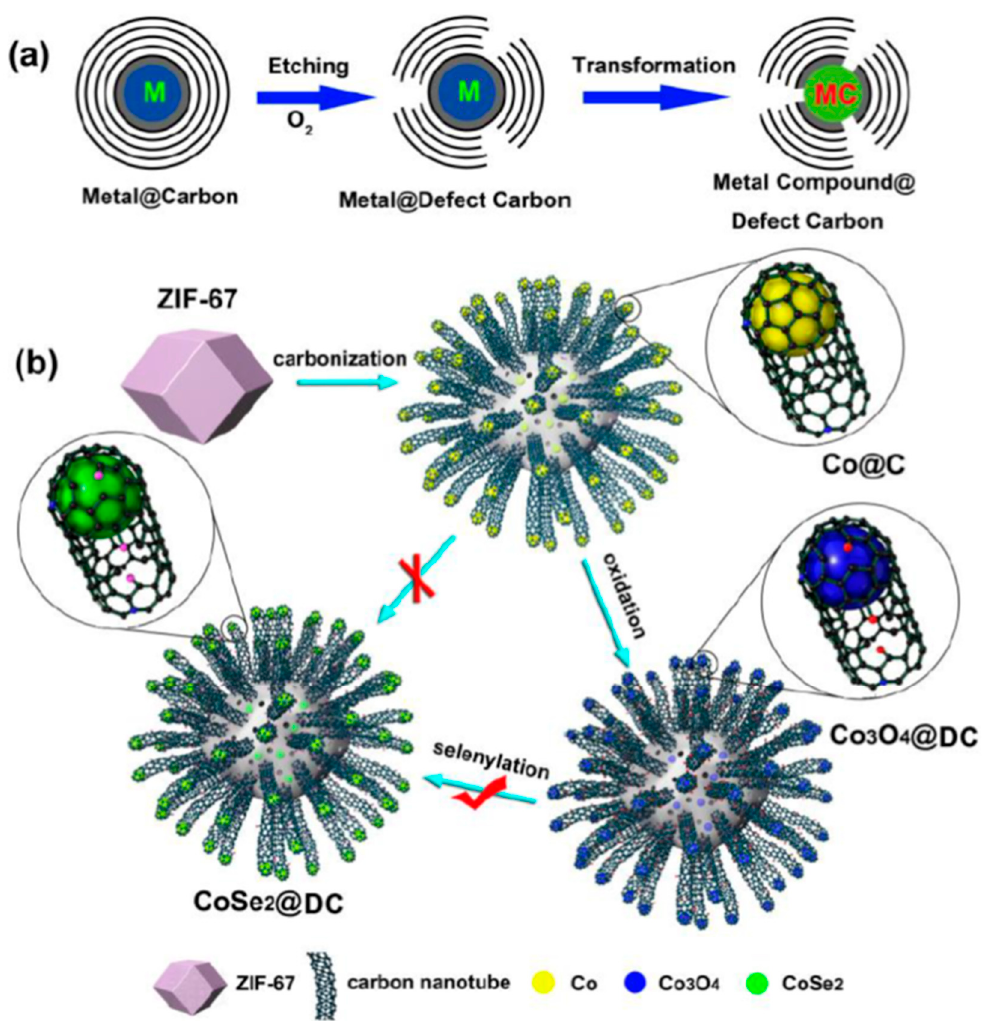
Figure 21. ( a ) Schematic illustration of the synthesis of CoS 2 /RGO; and ( b ) HER polarization curves (cathodic sweep) collected on different catalysts with mass loading of 0.285 mg cm − 2 in 0.5 M H 2 SO 4 acidic solution at a scan rate of 5 mV s − 1 at room temperature. Reproduced from [176], Copyright © Elsevier, 2017.